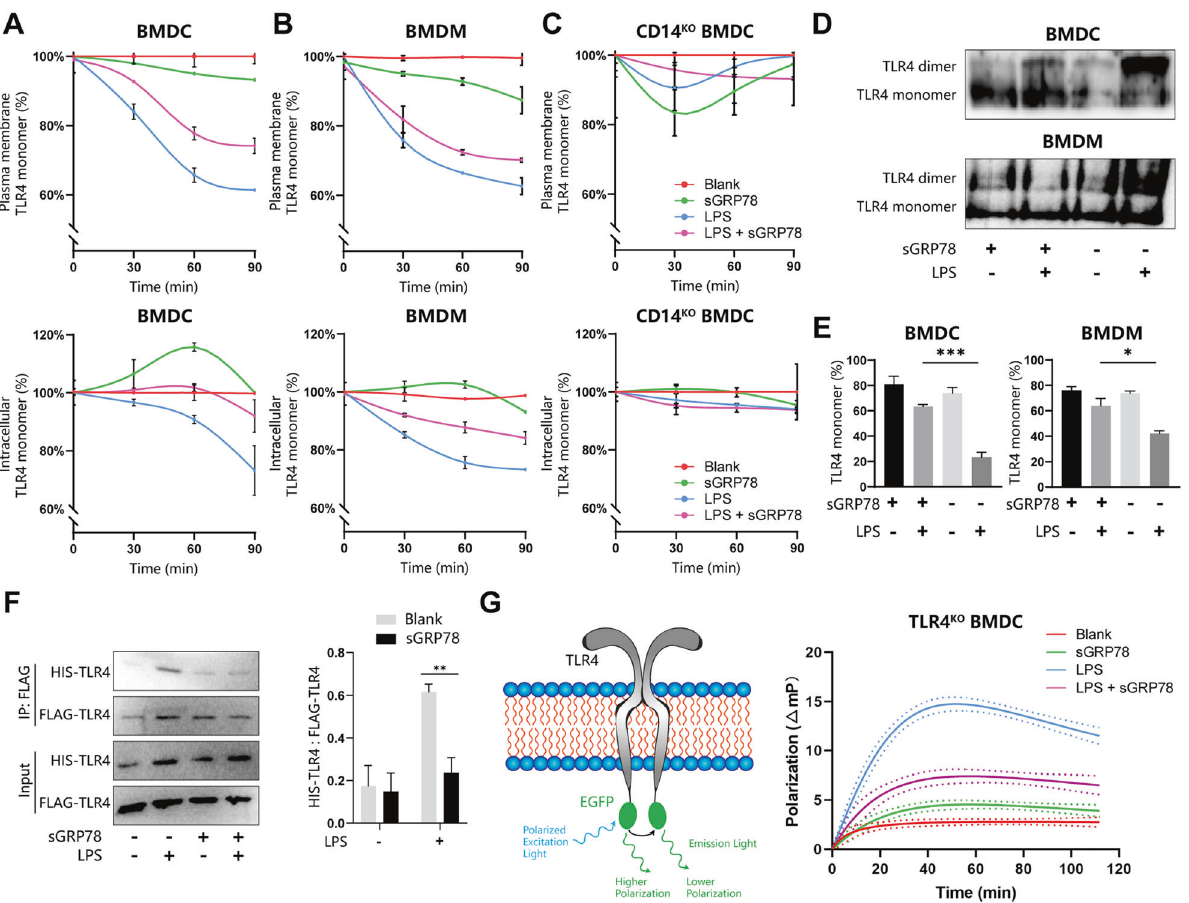
Fig. 2 sGRP78 promotes endocytosis of monomeric TLR4 in a CD14-dependent manner. BMDCs ( A ), BMDMs ( B ) and CD14 KO BMDCs ( C ) were treated with sGRP78 and/or LPS (100 ng/mL) for indicated minutes. Representative line chart of plasma membrane (upper) or intracellular (lower) TLR4 monomer were depicted. D Native PAGE for detection of the monomeric and dimeric TLR4. E Calculation of TLR4 monomer formation using the following formula: TLR4 monomer band/(TLR4 dimer band + TLR4 monomer band). F Tlr4 − / − BMDCs were co- transfected with pHIS-TLR4 and pFLAG-TLR4 for 48 h. Then cells were treated with sGRP78 and/or LPS for 3 h. Cell extracts were immunoprecipitated with anti-FLAG, probed with anti-HIS. G Schematic description for the mechanism of detecting monomeric